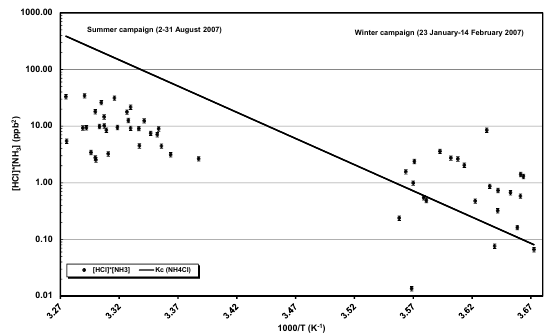
Fig. 7. Thermodynamically predicted equilibrium dissociation con- stant K c (black solid line) for pure NH 4 Cl and measured concen- tration product K mc =[HCl][NH 3 ] as a function of temperature for winter (right side) and summer (left side) seasons at Beijing. The K c and K mc constants have been determined by data collected on a 24-h